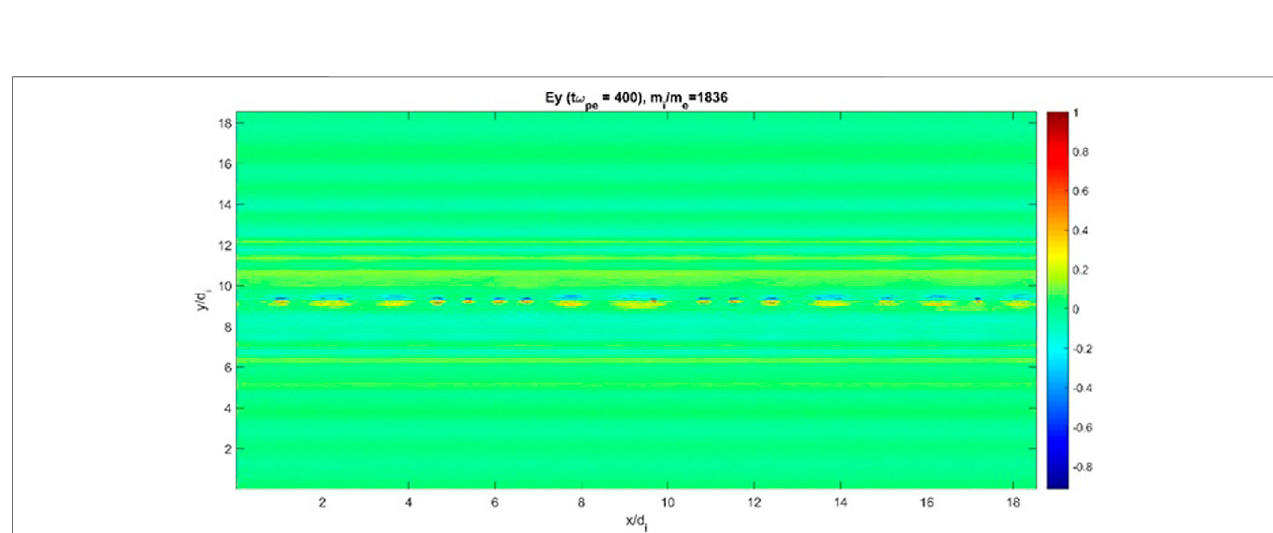
FIGURE 9 | E y plot at time t ω pe (cid:1) 400 for m i / m e (cid:1) 1836.